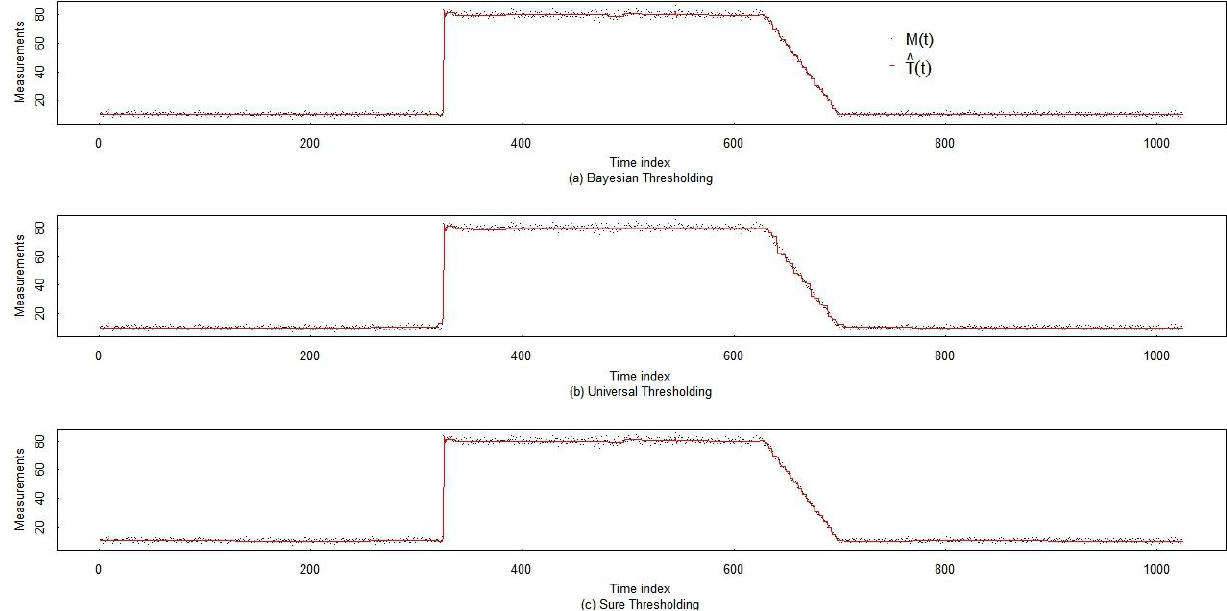
Figure 3. Smoothing base on bayesian, universal, and sure thresholding on simulated data. Bayesian thresholding appears to be the best method of de-noising this data.